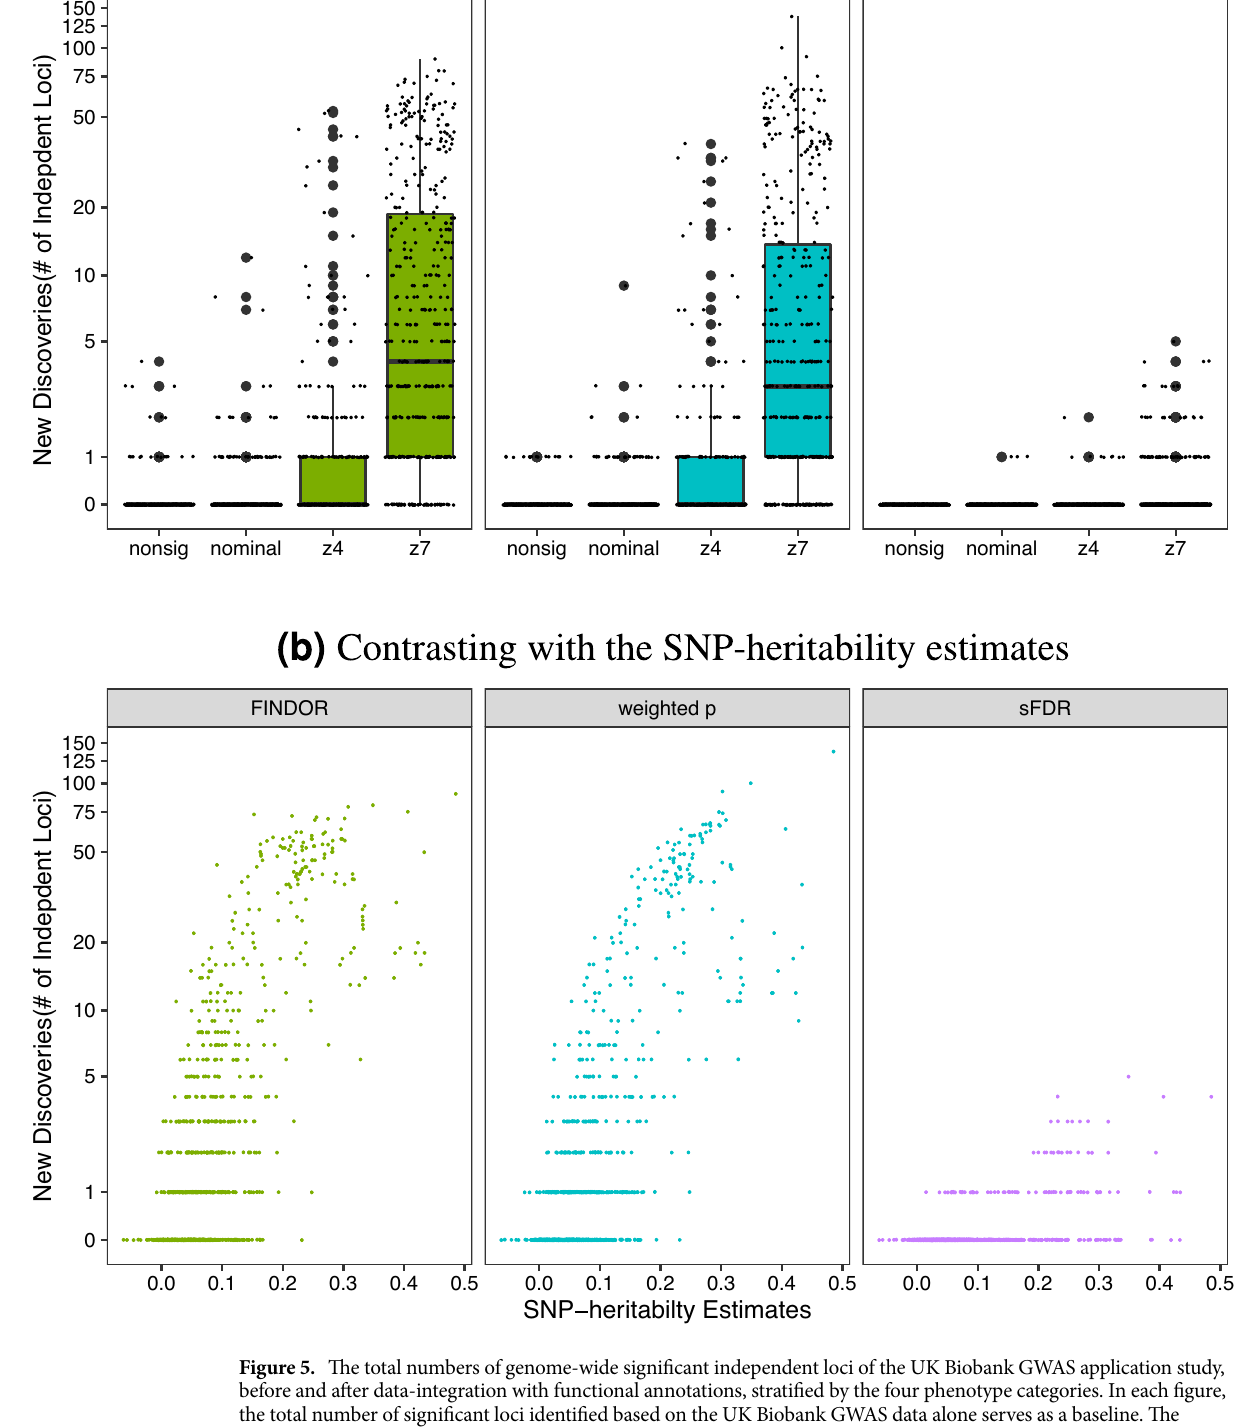
5 ), and z7 (438 traits; p < 1.28 12 ). 10 10 − − × ×